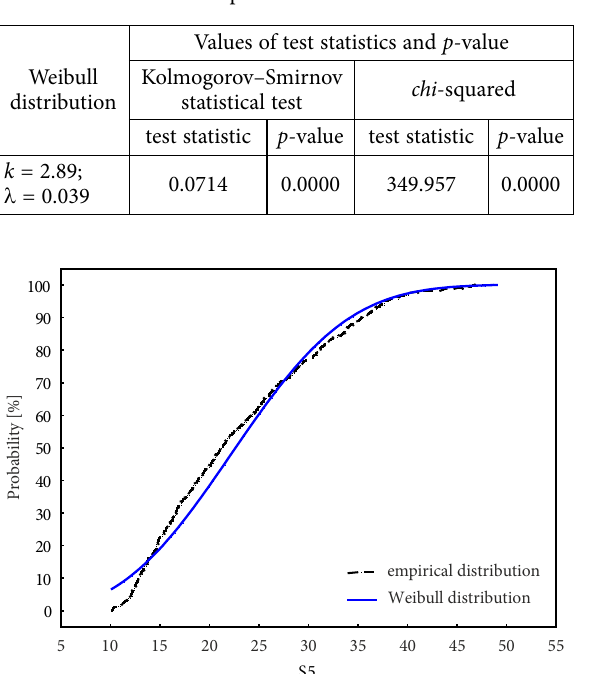
Table 3. Goodness of fit test results for theoretical